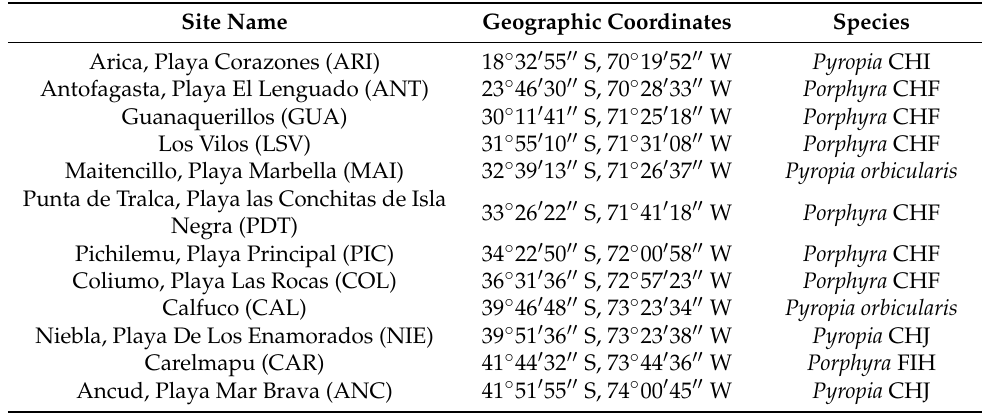
Figure 1. Specific activity of PDH (pyruvate dehydrogenase) during natural hydration (H) and desiccation (D) stress in the Porphyra and Pyropia species evaluated in this study. Values are the mean ± SD of three replicates. ARI, Arica; ANT, Antofagasta; GUA, Guanaquerillos; LSV, Los Vilos; MAI, Maitencillo; PDT, Punta de Tralca; PIC, Pichilemu; COL, Coliumo; CAL, Calfuco; NIE, Niebla; CAR, Carelmapu; and ANC, Ancud (see Table 1 and Figure 6 for in-depth information). Table 1. Study sites indicating the Porphyra and Pyropia species determined by morphological and molecular analysis according to